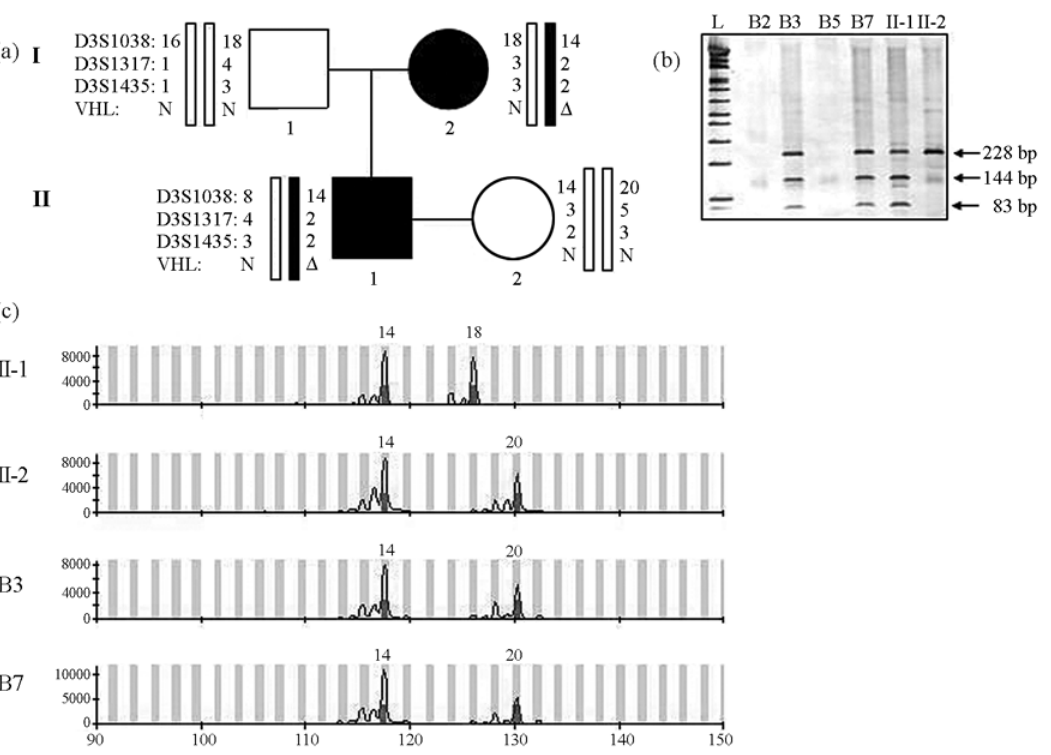
Figure 1 - Pedigree of the family with hereditary Von Hippel-Lindau (VHL) disease and analysis of blastomeres from the first in vitro fertilization (IVF) cycle. (a) Haplotype of linked microsatellite markers D3S1038, D3S1317 and D3S1435, and genotype regarding the 436delC mutation of the VHL gene (N = normal allele; Δ = mutant allele) are shown next to each individual. The affected individual (II-1) and his normal spouse (II-2) were informative for markers D3S1038 and D31317. (b) Analysis of 436delC mutation in blastomeres from embryos 2 (B2), 3 (B3), 5 (B5) and 7 (B7) of the first IVF cycle (blastomere number in parentheses). The mutation creates an Alu I restriction site generating 144 bp and 83 bp fragments from the normal 436delC 288 bp fragmentupondigestionwith Alu I.L=1kbplusDNALadder(Invitrogen).(c)ElectropherogramofmicrosatelliteD3S1038analysisofblastomeresfrom embryos 3 (B3) and 7 (B7). The lengths (bp) of the amplified products is represented on the bottom of the electropherograms. Allele numbers are indi- cated on the top of the corresponding